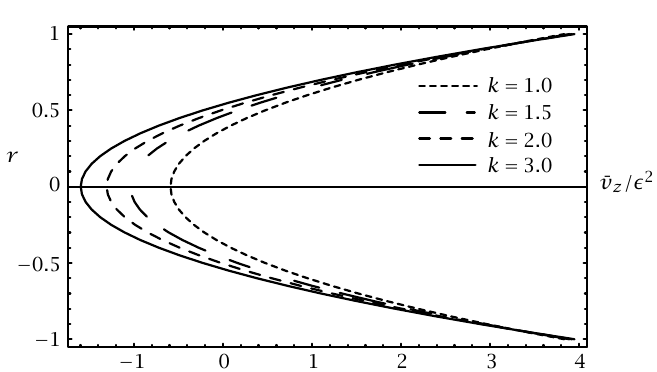
Figure 6.4 . The effect of the permeability parameter k on the mean-velocity distribution and reversal flow at Re = 5 . 0, (∂P/∂z) 2 = − 5, and α = 0 . 1.